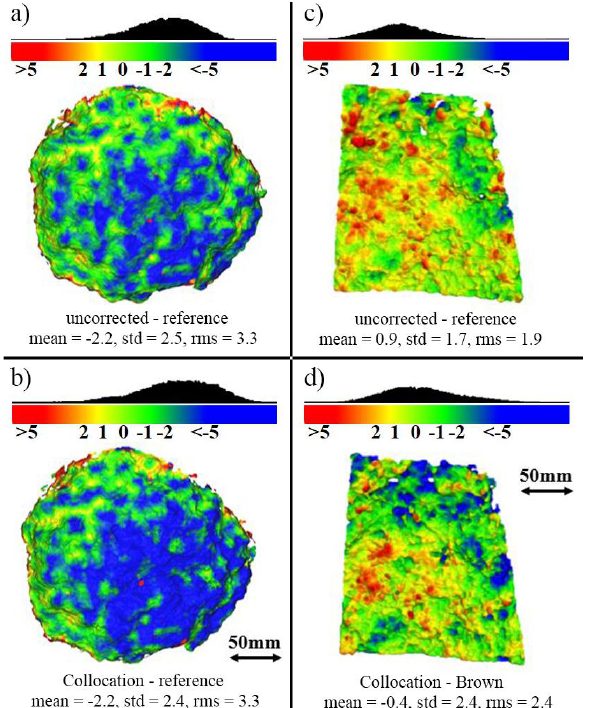
Figure 10. Comparison of dense point clouds for a single coral and ocean floor. The difference between the uncorrected GoPro and the collocated GoPro with the reference model are shown in a) and b). The same respective differences for the ocean floor are illustrated in c) and